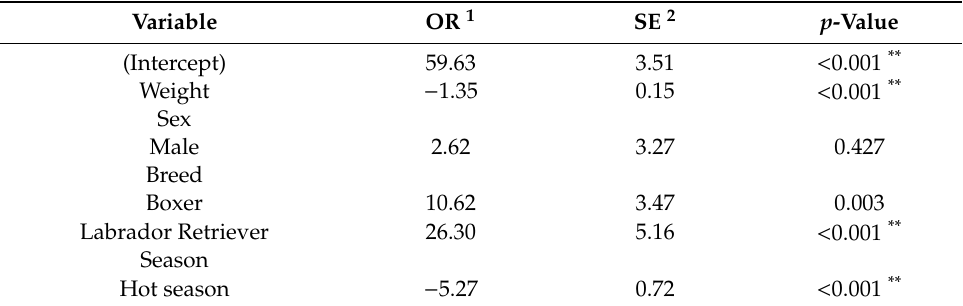
Table 3. Odds ratio and associated statistic of fixed e ff ects included in the final intake model of kennel